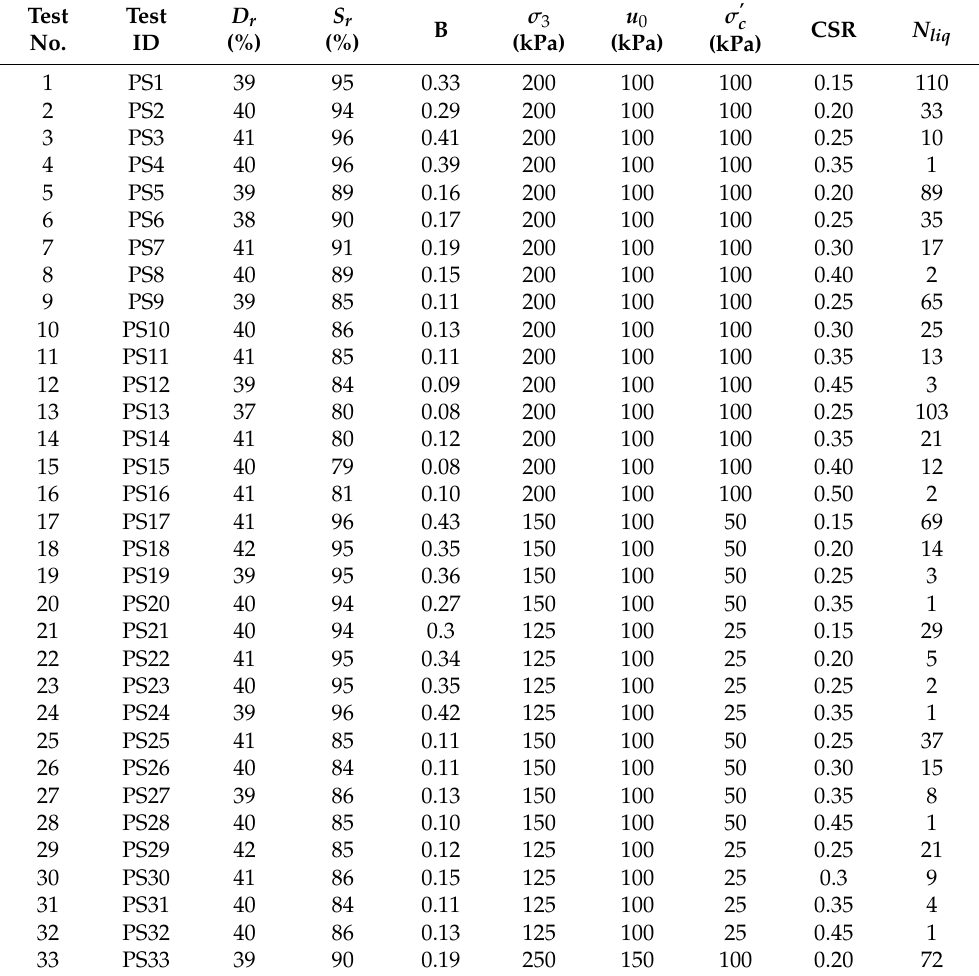
Table 3. Test parameters and typical results for partially saturated sand